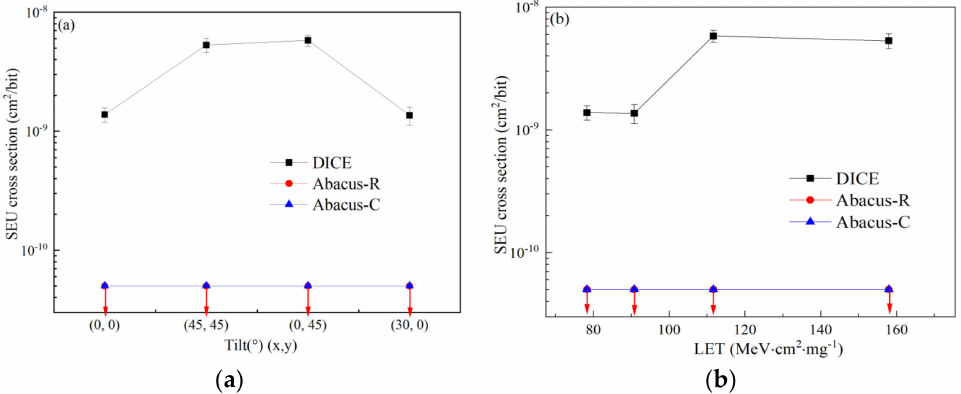
Figure 10. SEU cross section results for full “0” data under ( a ) different irradiation tilts, and ( b ) different LET values.